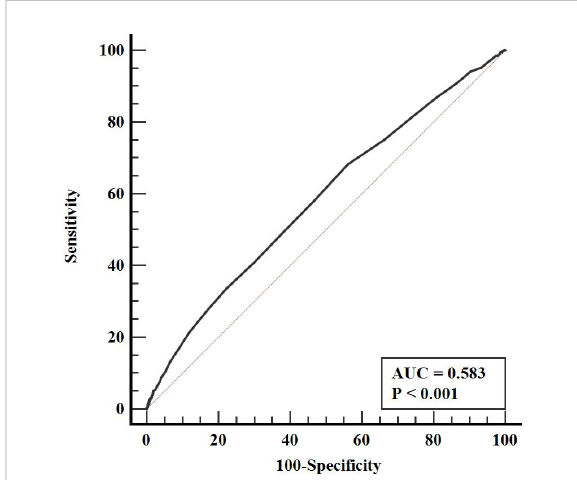
FIGURE 2 ROC curve evaluating diagnostic performance of HbA1c for incident hypertension. HbA1c, hemoglobin A1c; ROC, receiver operator characteristic; AUC, area under the